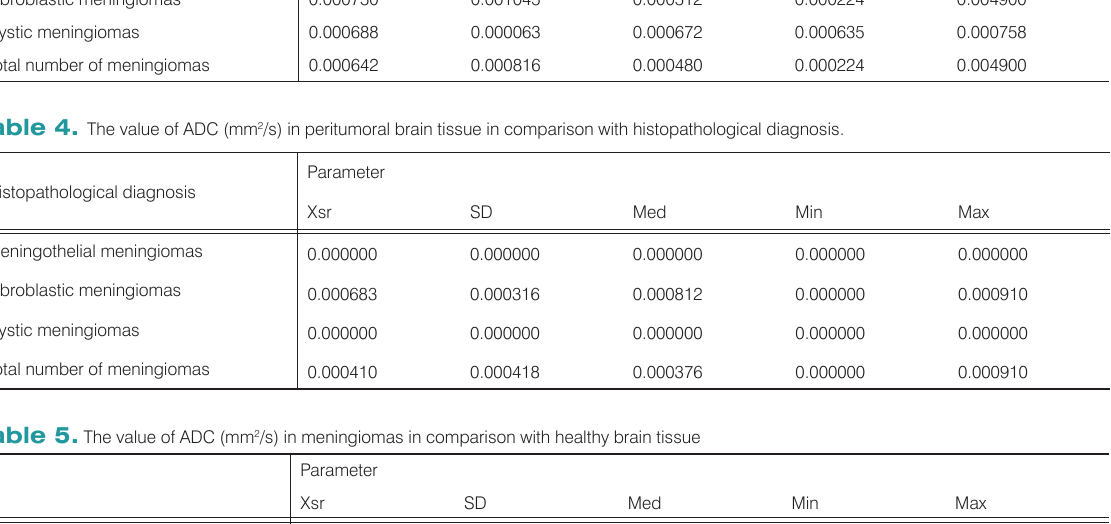
Table 5. ADC of meningeomas was higher comparing